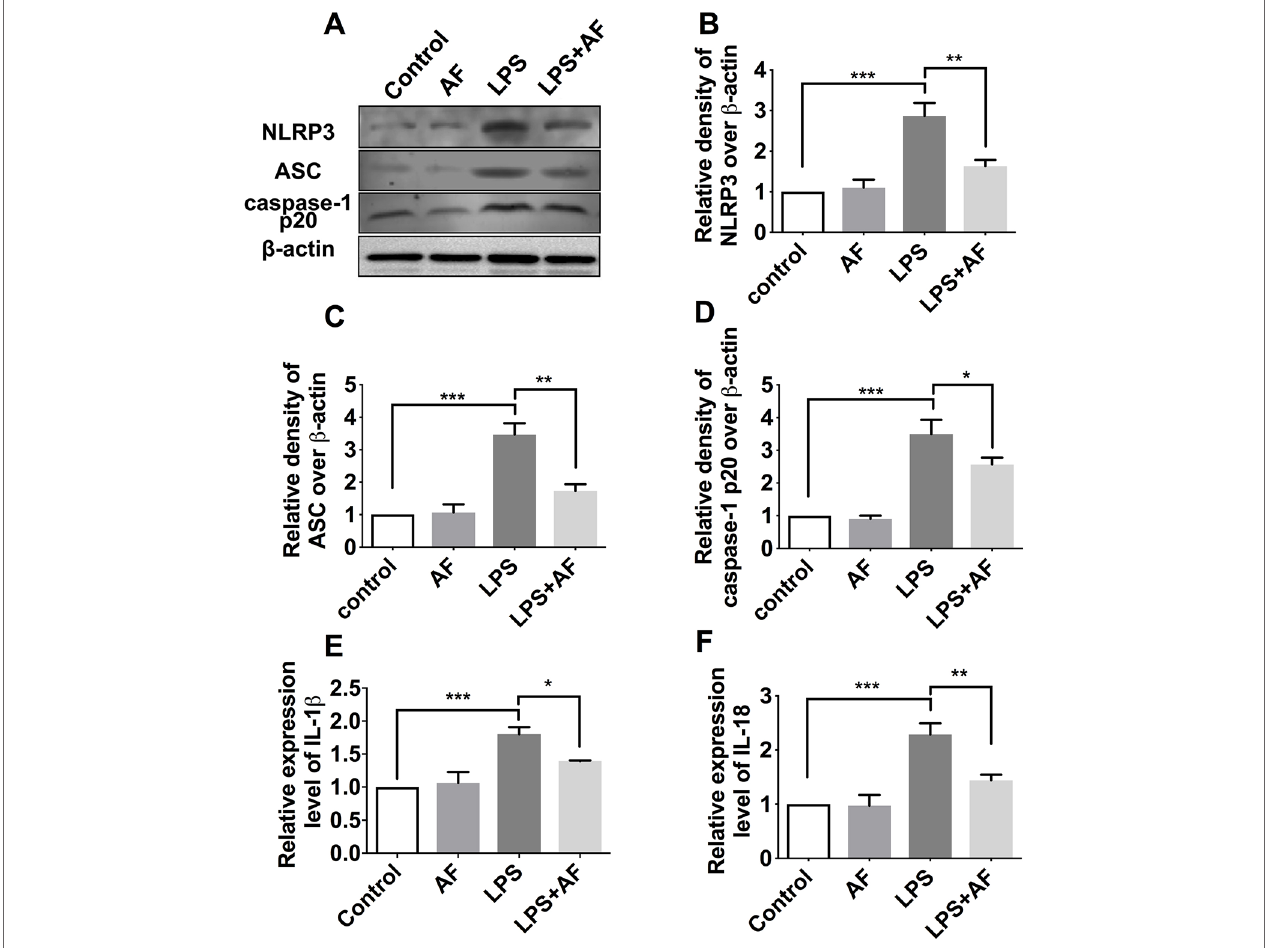
FIGURE 8 | Effects of amentoflavone on the protein expression of NLRP3 inflammasome activated by LPS in BV2 microglial cells. (A) Representative immunoblots of NLRP3, ASC, and caspase-1 p20 proteins in different groups. (B – D) Semi-quantitative analysis of the relative levels of NLRP3, ASC, and caspase-1 p20 by densitometric analysis ( Student’s t test ). (E and F) Semi-quantitative analysis of the relative levels of IL-1 β and IL-18 using ELISA ( Student’s t test ). Error bars represent mean ± s.d. *, **, *** represent p < 0.05, p < 0.01, p < 0.001, respectively. All experiments were performed in triplicate. LPS, lipopolysaccharide; AF,